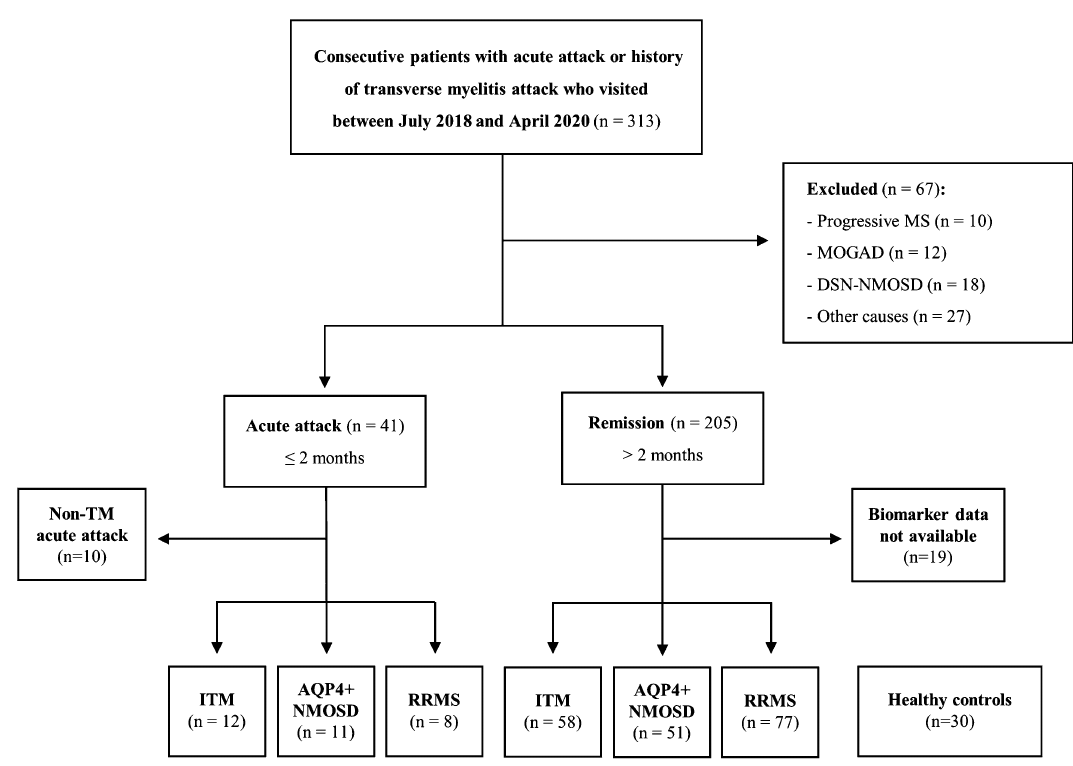
Figure 1. Flowchart of patient distribution. The chart shows the distribution of 313 consecutive patients who visited our center during the study period. “Acute attack” stands for a clinical attack within the last two months. ITM: idiopathic transverse myelitis; AQP4 + NMOSD: aquaporin-4 antibody-positive neuromyelitis optica spectrum disorder; MS: multiple sclerosis; RRMS: relapsing–remitting multiple sclerosis; MOGAD: myelin oligodendrocyte glycoprotein antibody-associated disorder; DSN-NMOSD: double seronegative neuromyelitis optica spectrum